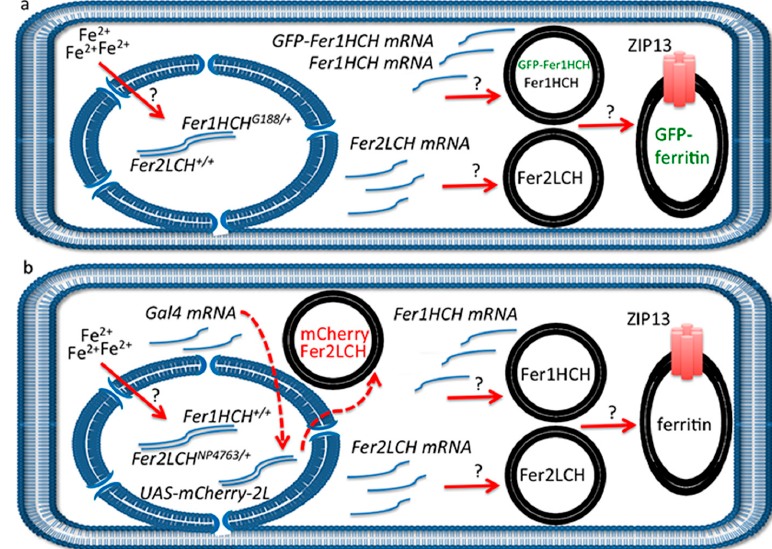
Figure 5. ( a ) Schematic representation of anterior midgut enterocyte from Fer1HCH G 188 /+ larvae at